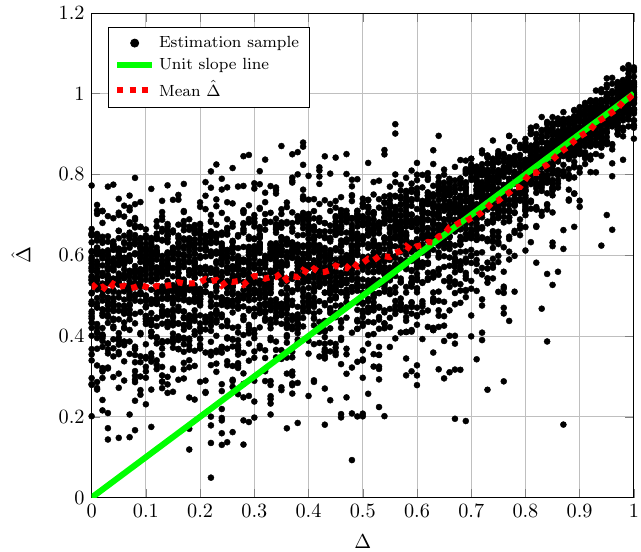
Figure 4. Samples of ˆ ∆ Equation (16) vs. true ∆ for K =